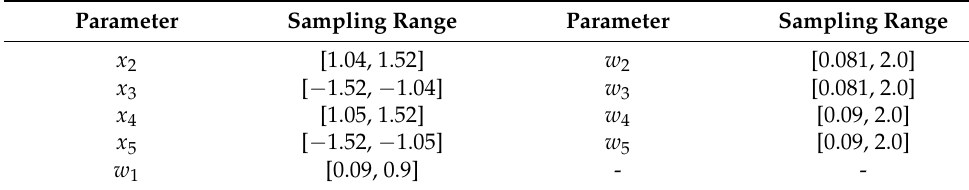
Table 9. Parameters’ sampling range of pattern-2.